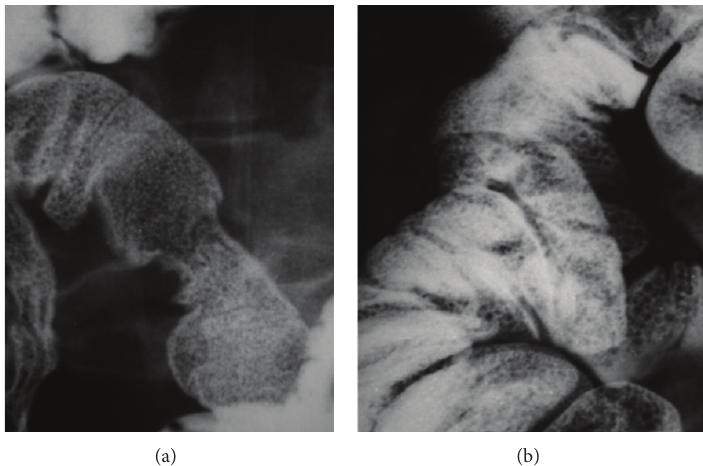
Figure 3: Small bowel follow through: multiple well defined, round, small filling defects all over the